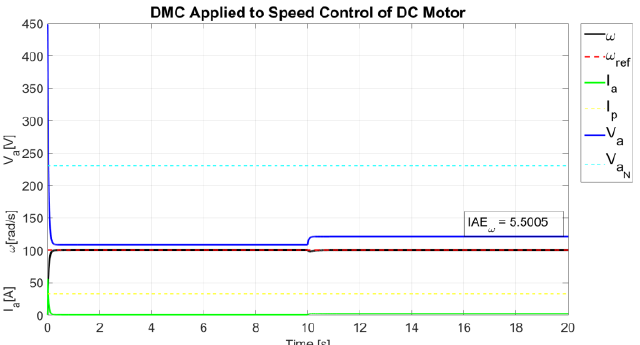
Figure 10. DC motor speed for system controlled by DMC tuned by AG for set-point ωref = 50 rad/s applied for set-point ωref = 100